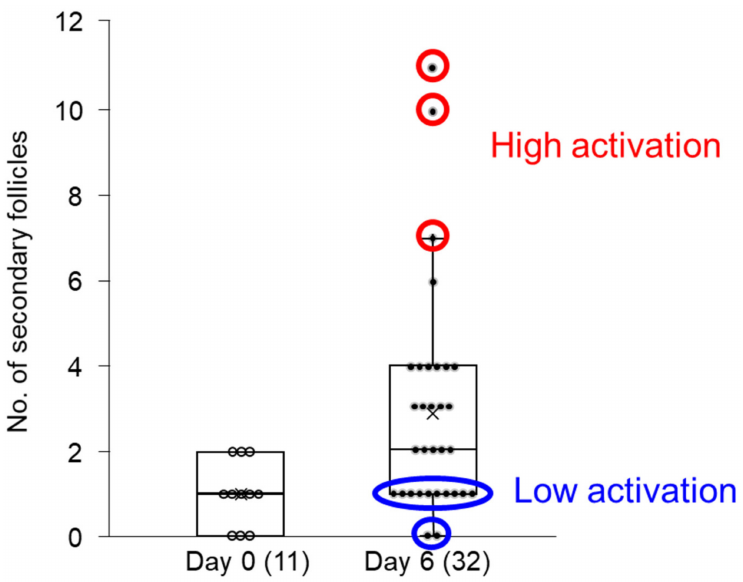
Figure 3. Distribution of the number of secondary follicles on days 0 and 6 of culture. Lines on the boxes delineate the 25th, 50th, and 75th percentiles, whereas the whiskers depict the minimum values or 1.5 times the interquartile range. X markers mean averages. Samples selected as the high activation group were marked by a red circle, while samples selected as the low activation group were marked by a blue